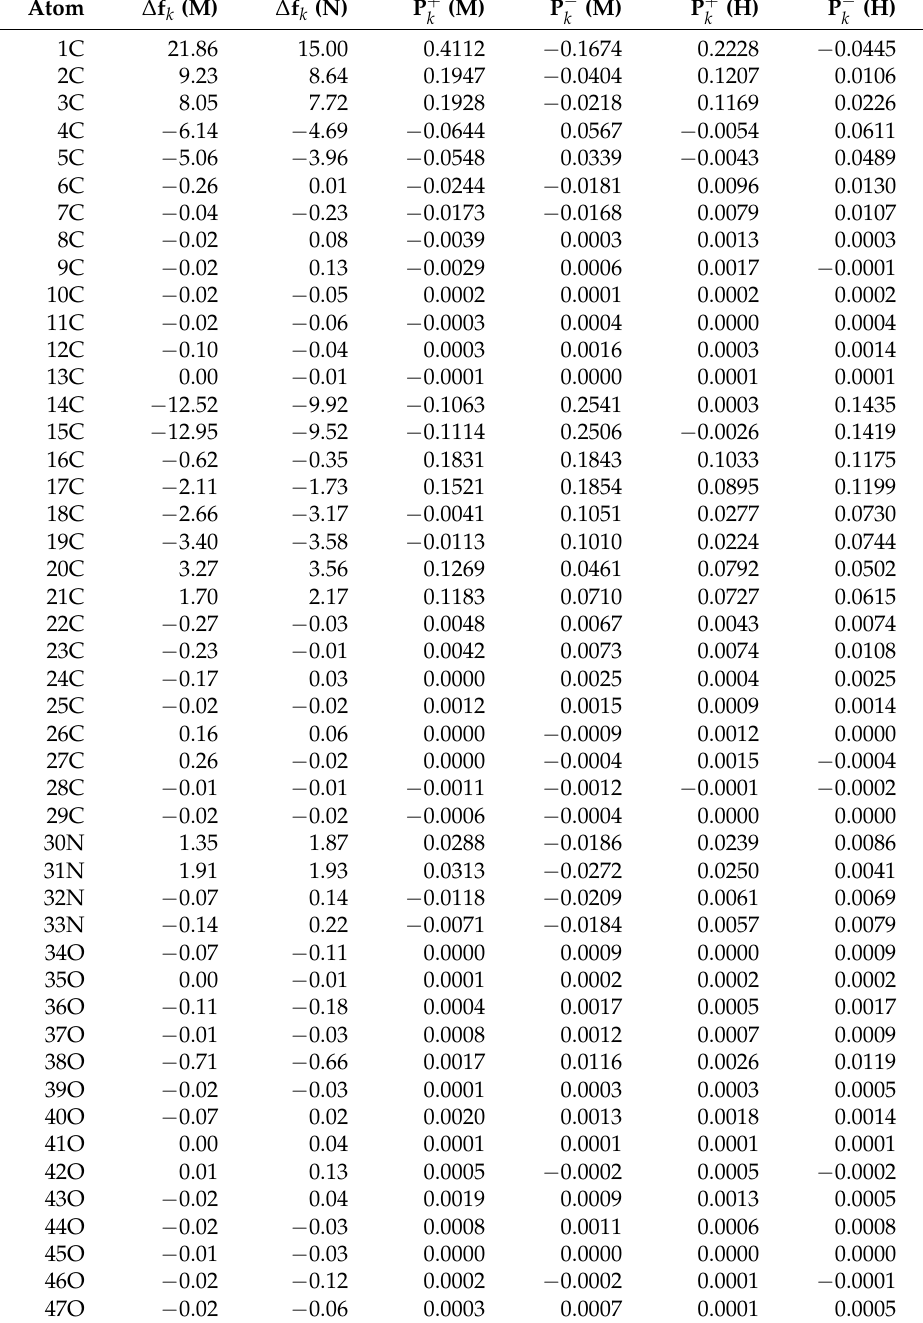
Table 4. The condensed dual descriptor calculated with Mulliken atomic charges ∆ f k (M) and